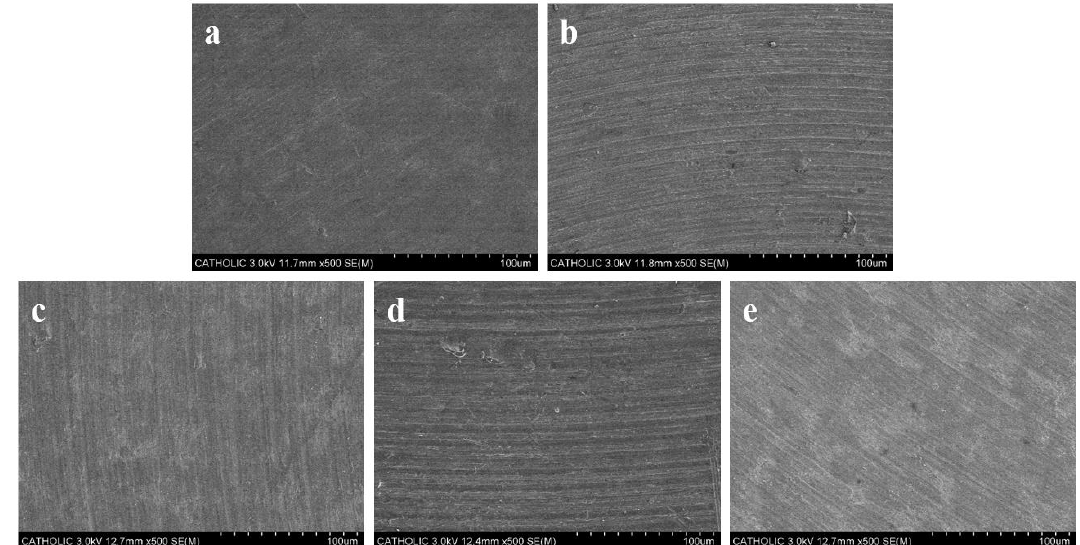
Figure 3. Scanning electron microscope (SEM) images of ( a ) Ti, ( b ) Hepa/Ti, ( c ) PDGF/Hepa/Ti, ( d ) BMP/Hepa/Ti, and ( e ) PDGF/BMP/Hepa/Ti.